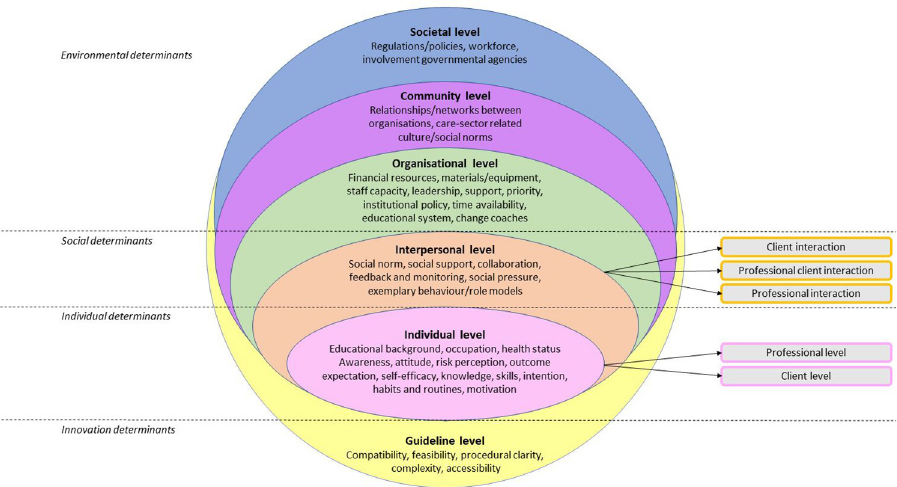
Fig 1. The integrated theoretical framework for factors influencing IPC in disability care settings, informed by various implementation science theories [17, 22–30], adapted to the results of our qualitative analysis. The integrated theoretical framework includes the guideline (yellow), individual (pink), interpersonal (orange), organisational (green), community (purple) and societal level (blue). The individual level comprises the client and professional level. The interpersonal level includes professional interaction, professional client interaction, and client interaction. The division of levels is based on the theories of Grol and Wensing [17, 22], Flottorp et al. [23] and socio- ecological models [30]. The interview data revealed that on the social context next to professional interaction [17, 22], professional client interaction and client interaction were important levels on which barriers and facilitators may occur. The underlying concepts of every level are based on various implementation science theories [17, 22–30], adapted to the data from our qualitative